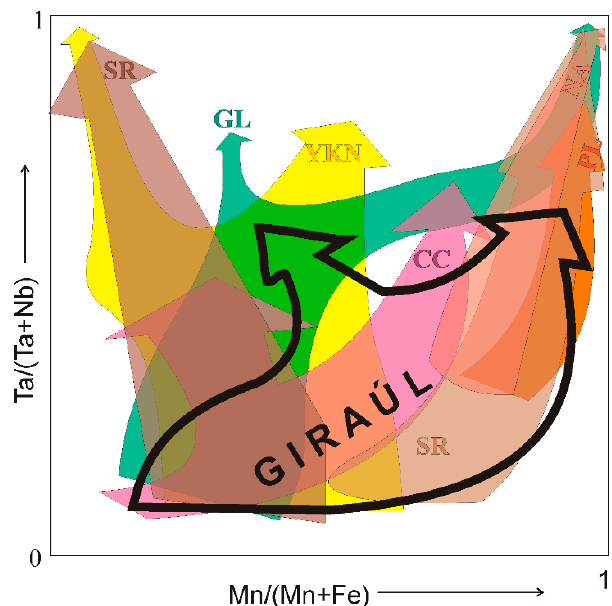
Figure 25. Comparison of the evolution trend of the chemical composition of CGM from the pegmatite field of Giraúl (thick line) with other evolved pegmatite fields. CC, Cap de Creus [31]; SR, Separation Rapids pluton [68]; PL, Pakeagama Lake [80]; YKN, Yellowknife [77]; NA, North Aubry [81]; GL, Greer Lake [72].